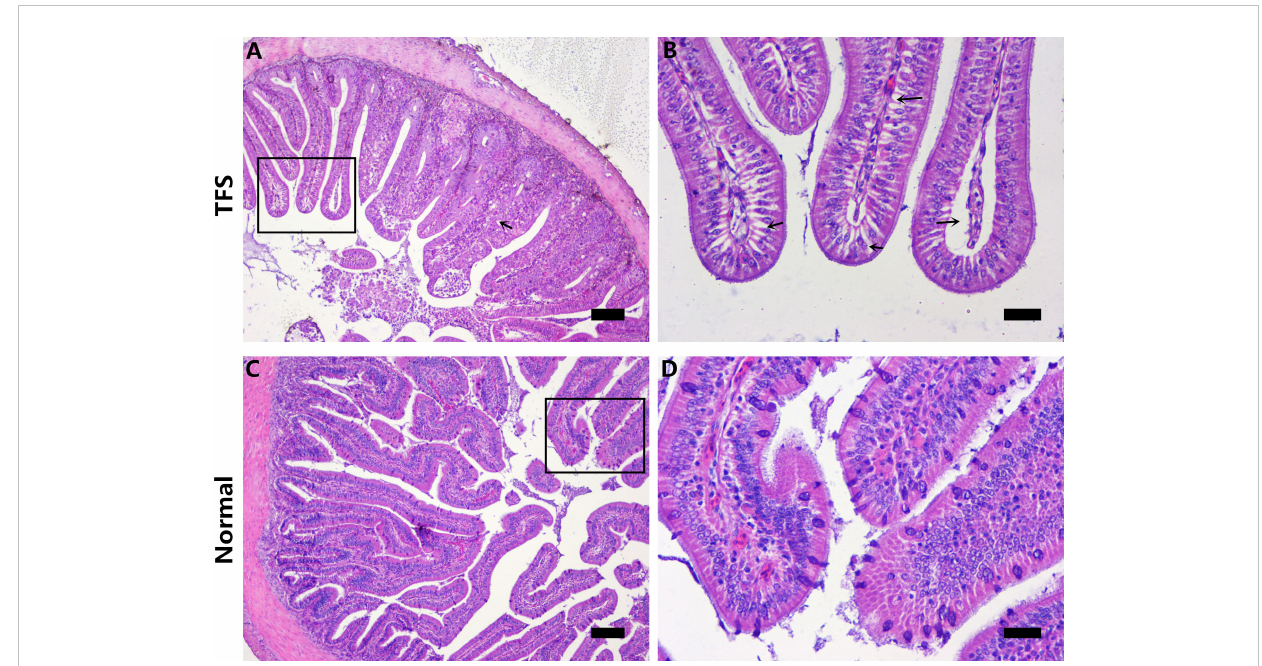
FIGURE 2 Histological analysis of the intestinal sections of normal (NOR) and TFS D. hystrix . (A) The histological of TFS D. hystrix . (B) High magni fi cation of the boxed areas in A, black arrows indicate the cavitation and voids. (C) The histological of normal D. hystrix . (D) High magni fi cation of the boxed areas